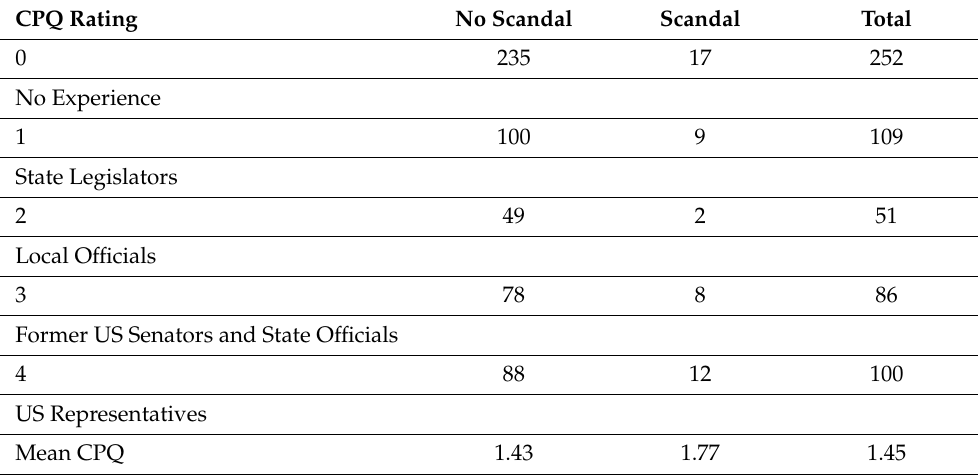
Table 3. Challenger political quality (CPQ). US—United